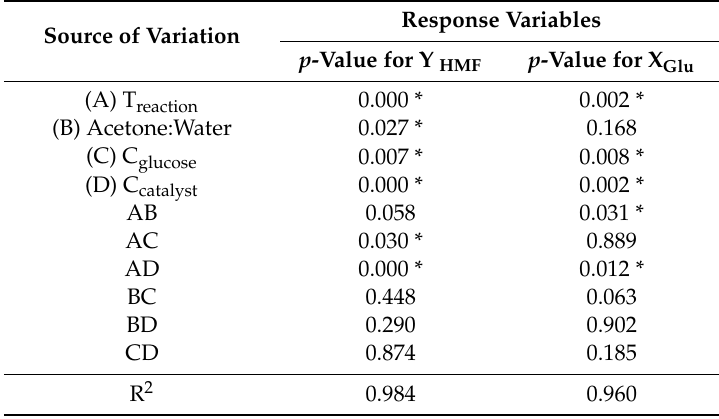
Table 5. Analysis of variance of response variables evaluated in the experimental design Taguchi L 16 . Response Source of Variation